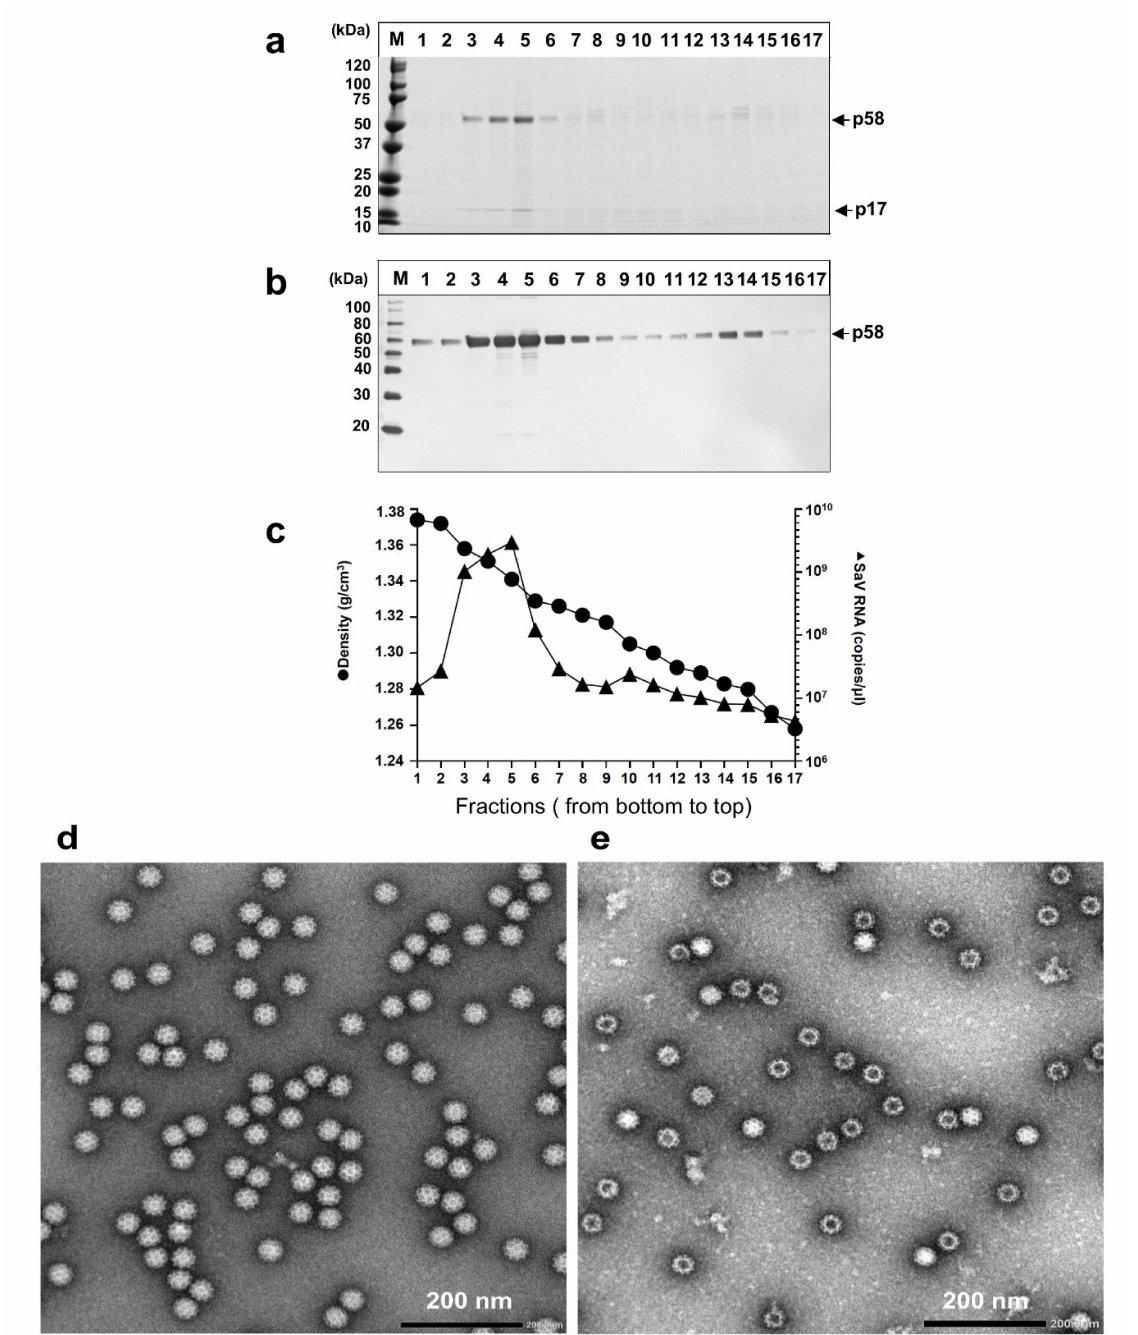
Figure 2. Purification and characterization of AK11 virions. The p1 supernatants collected on day 8 p.i. were concentrated by ultracentrifugation and then purified by CsCl equilibrium density gradient centrifugation. Aliquots from each fraction were analyzed by electrophoresis on 5–20% polyacrylamide gels and stained with CBB ( a ), and the capsid protein was detected by a Western blotting assay using a VP1-specific antiserum ( b ). Molecular weight markers (in kDa) are indicated on the left ( a , b ). Viral RNA in each fraction ( (cid:78) ) detected by RT-qPCR and the density ( Electron micrographs of fractions 5 ( d ) and 13 ( e ). Bar: 200 nm. The particle sizes were determined using Hitachi EMIP software ver. 0524 (Hitachi High Technologies, Tokyo,